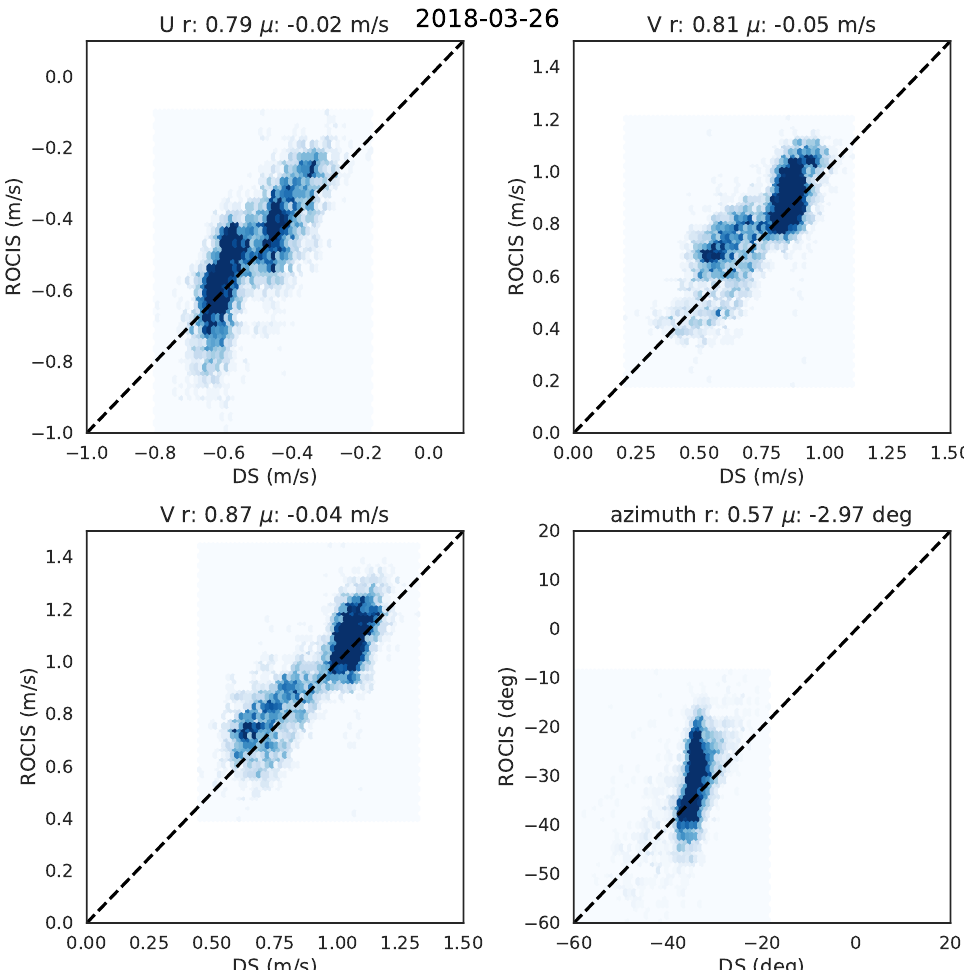
Figure 21. Hexbin scatterplot comparing DopplerScatt ( x -axis) versus ROCIS ( y -axis) measurements of U ( upper left ), V ( upper right ), speed ( lower left ), and azimuth direction relative to north ( lower right ). The Pearson correlation coefficient, r , and mean offset, µ , for each quantity is shown above the respective figure. Data for 26 March